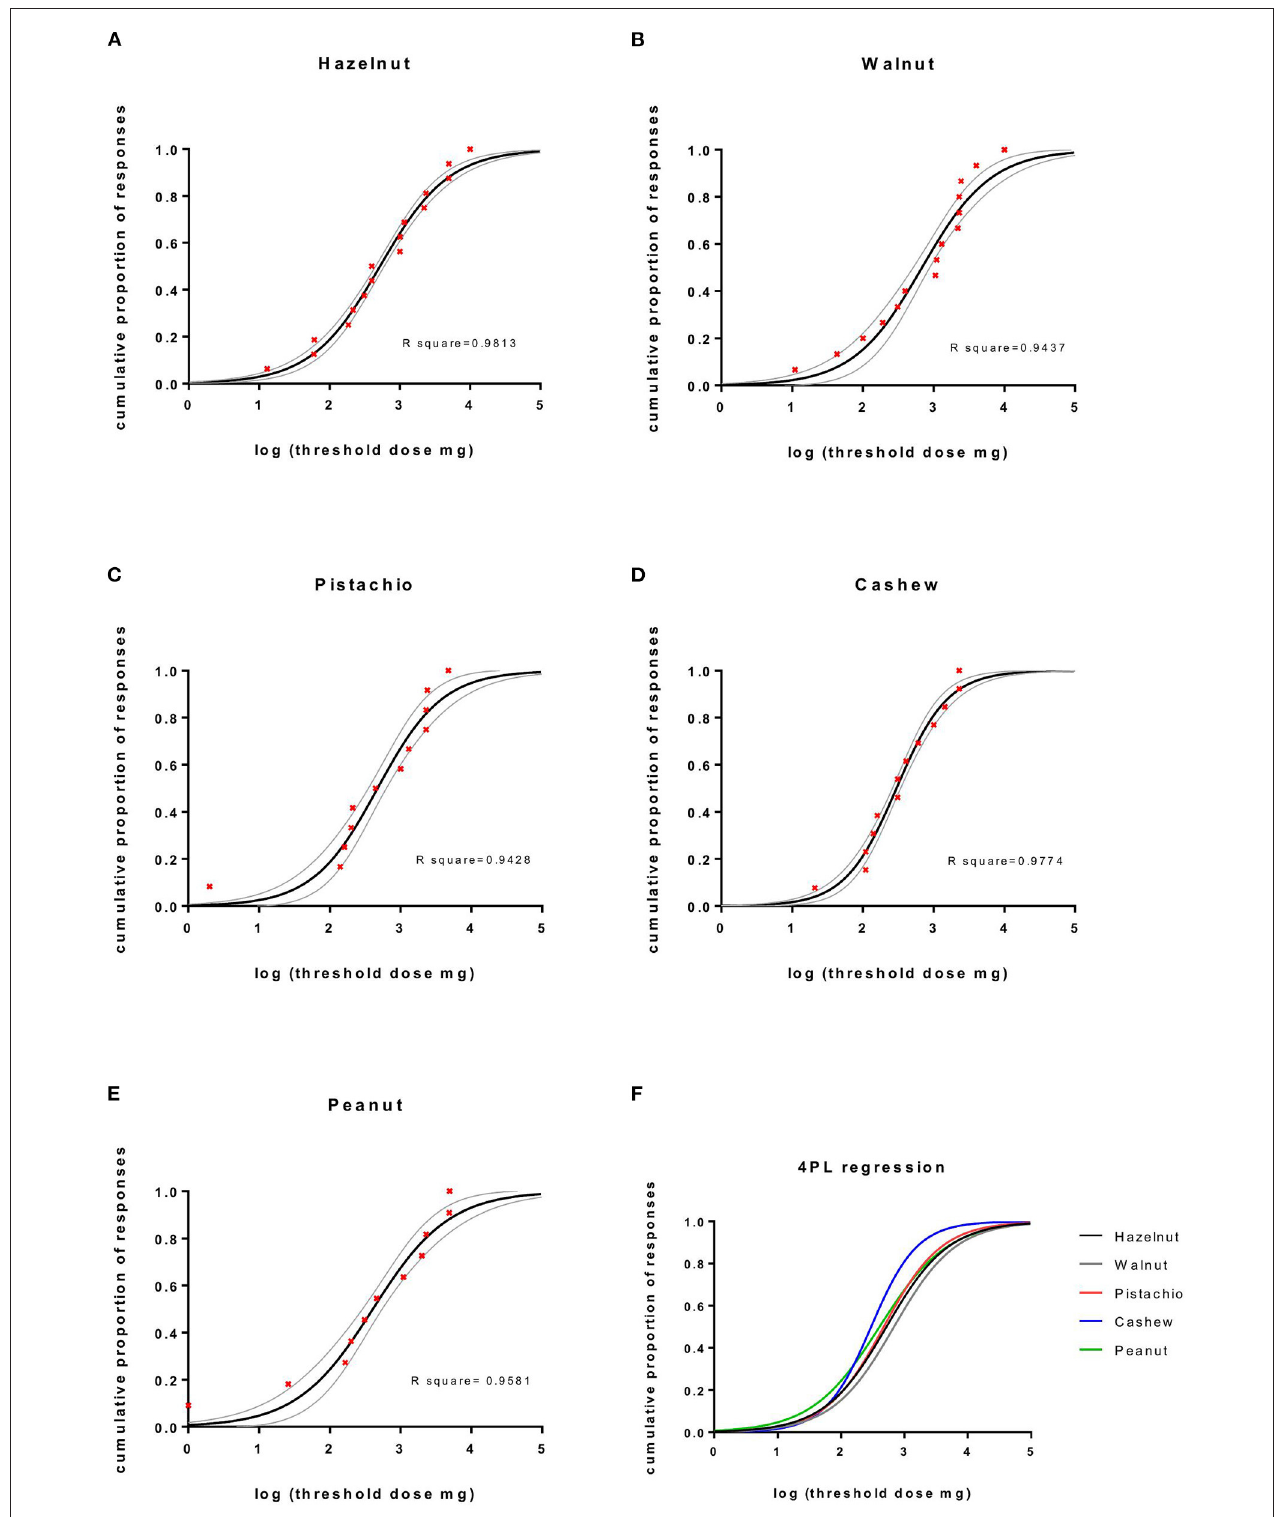
FIGURE 2 | The cumulative proportion of responses against the threshold doses to five nuts. Four parametric logistic regression curves (constraints top = 1, bottom = 0). (A–E) The cumulative proportion of responses against log threshold doses of nuts, 95% CI and (F) combined dose-response curves.